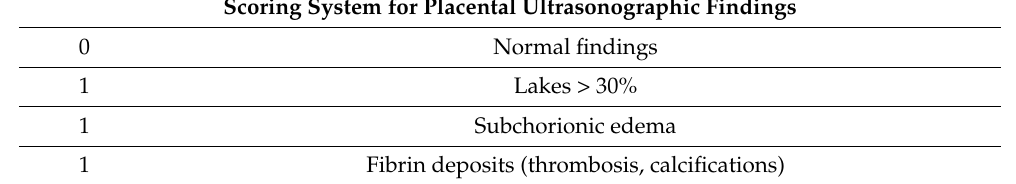
Table 1. Scoring system for placental ultrasonographic findings: each finding is associated with 1 point. The total score, ranging from 0 to 3, is calculated by the sum of the following points. Scoring System for Placental Ultrasonographic Findings 0 Normal findings 1 Lakes > 30% 1 Subchorionic edema 1 Fibrin deposits (thrombosis,